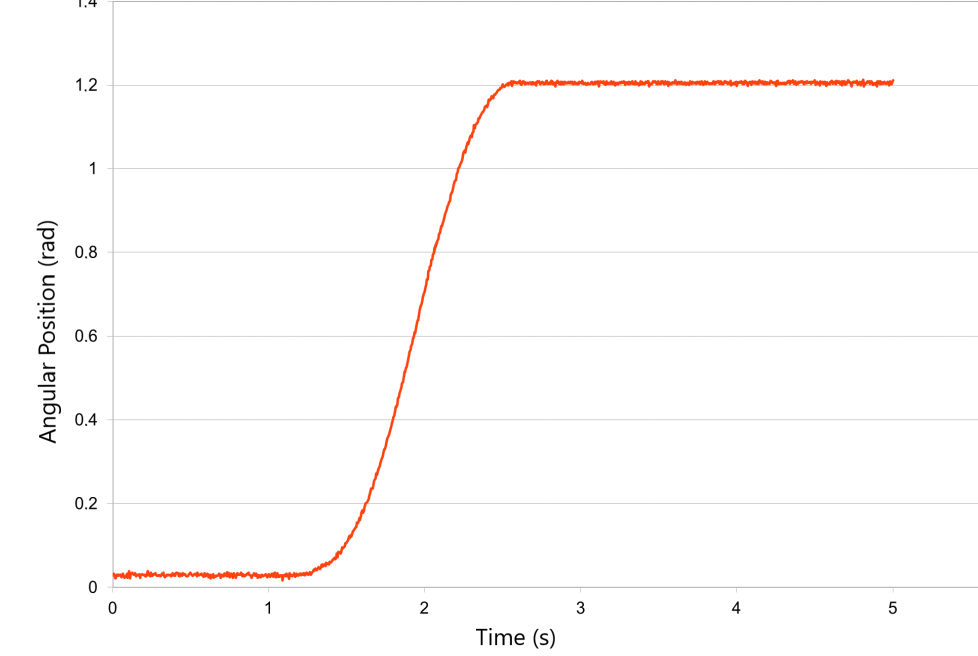
Figure 17. Position and Velocity Controllers, Profiles